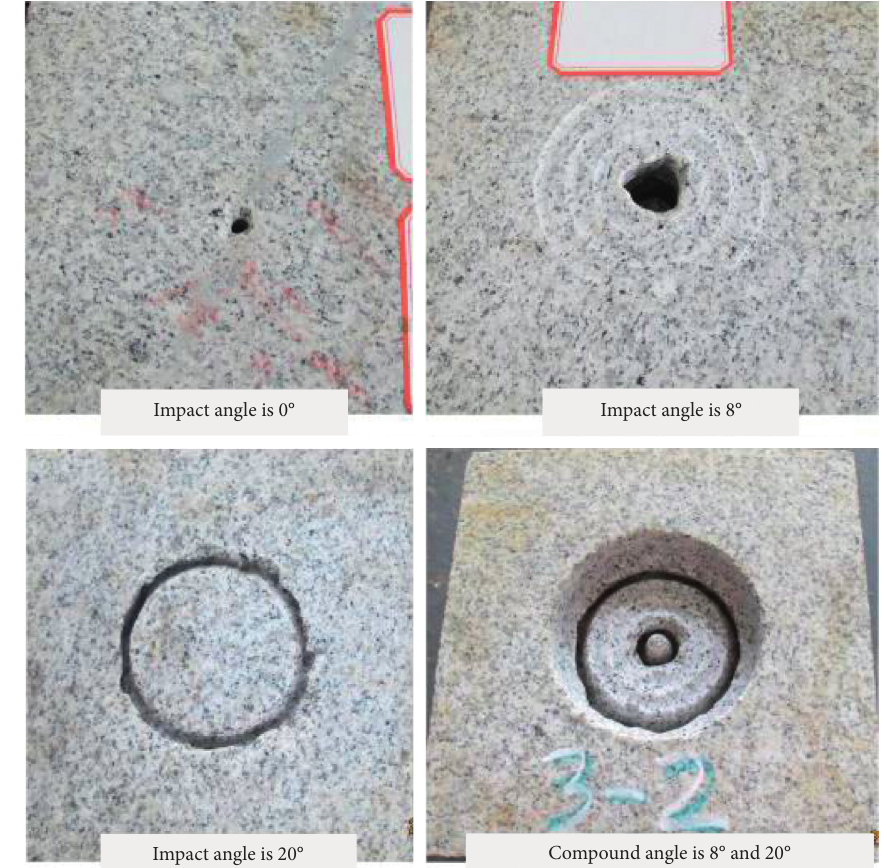
Figure 2: The rock-breaking